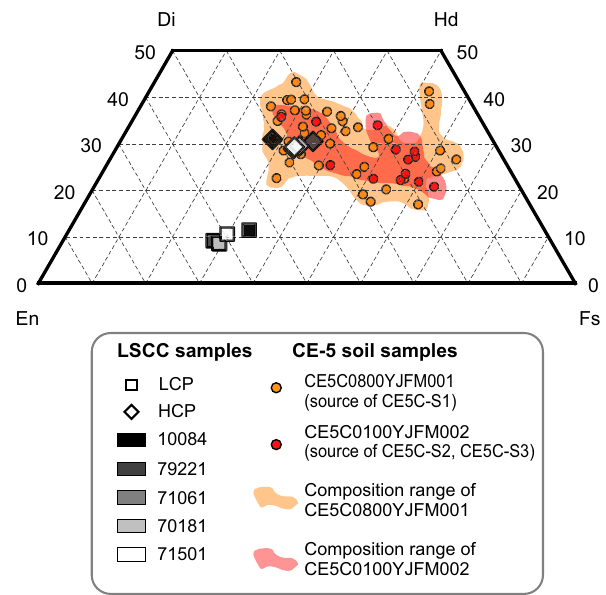
Fig. 5 | Pyroxene quadrilateral showing pyroxene compositions for CE-5 soil samples and Lunar Soil Characterization Consortium (LSCC) high-Ti mare soil samples. LSCC samplesareshownin white to black color, and different geometric shapes represents different pyroxene compositions. Note that the pyroxene is divided into four types by LSCC, including orthopyroxene, pigeonite, Mg- Clinopyroxene and Fe-Clinopyroxene 44 . To simplify, we regard the weighted aver- age composition of orthopyroxene and pigeonite as the composition of low-Ca clinopyroxene (LCP),and the weighted averagecomposition of Mg-Clinopyroxene andFe-Clinopyroxeneasthecompositionofhigh-Caclinopyroxene(HCP).ForCE-5 samples, thoughwedo notobtainthe speci fi cpyroxene compositionsofthe three spectroscopic analyzed samples, the pyroxene compositions of the two source samples were measured and could be considered as representative of the approximate compositions of these three samples. The corresponding data are from ref. 33. The pyroxene compositions of low-Ti mare soil samples are not compared because they were not provided by LSCC. The fi ve-digit number (e.g., 10084) corresponds to the Apollo sample number. Di, Hd, En, Fs represent diop- side, hedenbergite, enstatite, and ferrosilite,